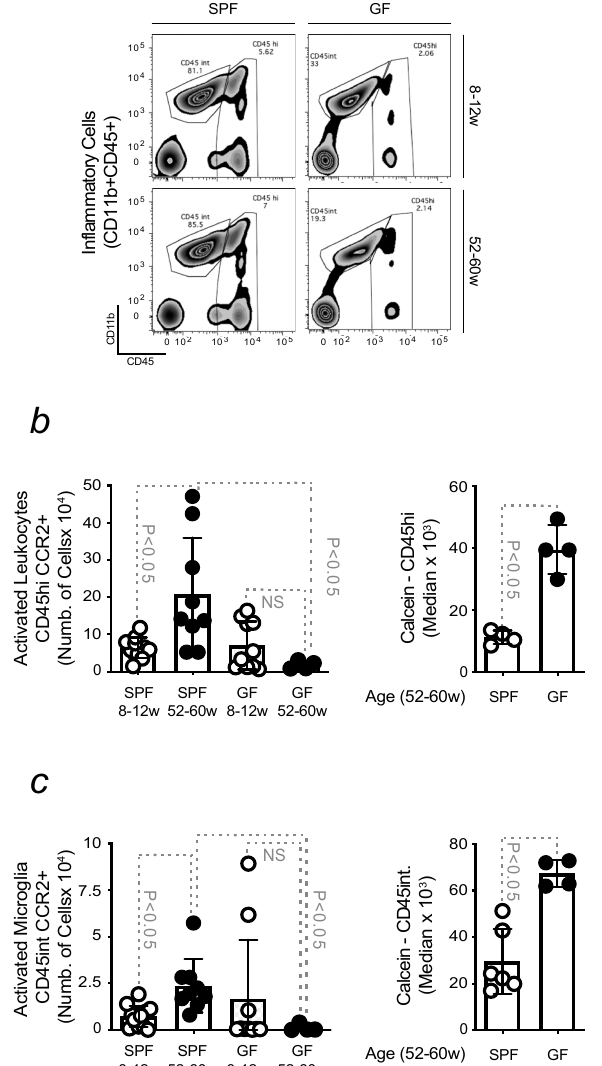
Figure 6. Reduced neuroinflammation and intracellular Fe accumulation in the brain of old GF mice. Gating strategy of ( a ) freshly isolated infiltrated leukocytes (CD45hi) and microglia (CD45int), within contour plots, from the brain of young vs. old conventional vs. GF mice. ( b ) Total number of activated infiltrating leukocytes in the brain of young and old mice, maintained in conventional or gnotobiotic conditions, and calcein median fluorescence intensity for CD45hi from aged animals ( c ). Total number of activated microglia in young and old mice, maintained in conventional or gnotobiotic conditions, and calcein median fluorescence intensity for CD45int from aged animals. The results were expressed as mean ± SD ( n = 4–11 mice per group). Statistical analysis was performed by applying non-parametric Mann–Whitney Test.